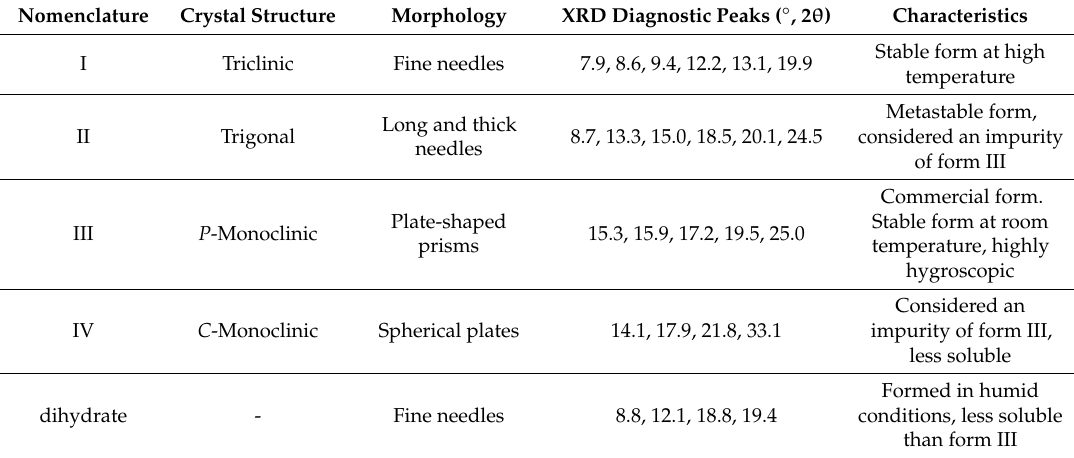
Table 2. Nomenclature and main properties of the four CBZ polymorphs and the